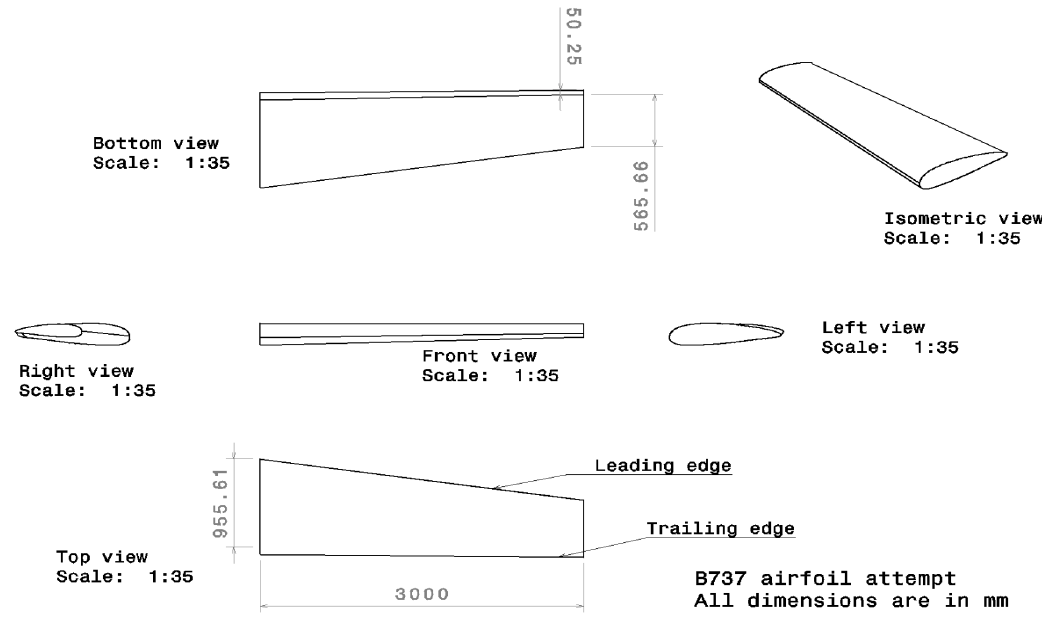
Figure 3. Design draft of airplane wing.